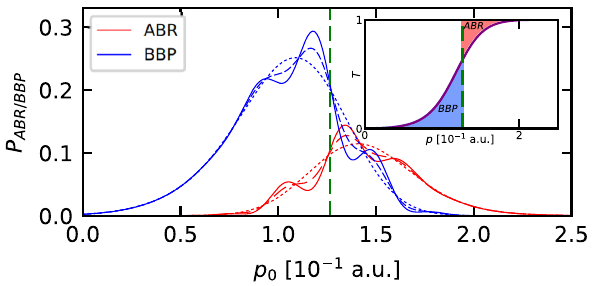
Figure 3. Probabilities of BBP and ABR for the initial DSC-state interacting with the Gaussian barrier. Solid, dashed, and dotted lines correspond accordingly to Ŵ = 1 , Ŵ = 0.5 and Ŵ = 0 ; the vertical green dashed line corresponds to the momentum p B . The inset shows the transmission coefficient T ( p ).